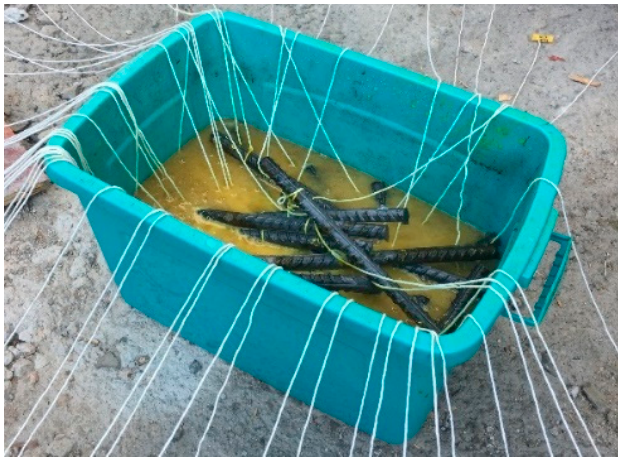
Figure 8. Cleaning with HCl solution.